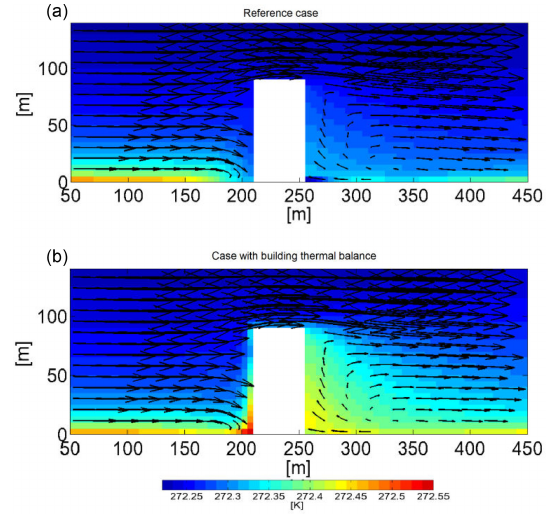
Figure 7. Vertical cross section at the center of a high-rise build- ing located in Hamburg (Germany) on 1 February at 13:30 parallel to the wind direction. Colors show the potential temperature of the air surrounding the building and arrows depict the wind circulation for both the reference case (no thermal energy exchange between building façades and environment, a ) and the case with full model physics as described in Sect. 4.2 (b) . Comparing both cases indi- cates that the air is slightly heated up by the buildings, especially in the building stagnation and wake regions.